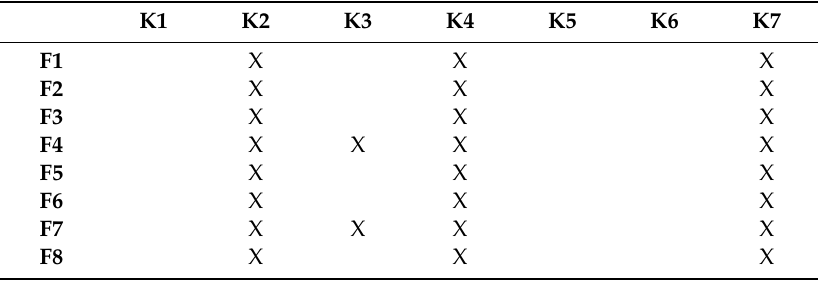
Table 8. Necessary knowledge versus VMEA weights.